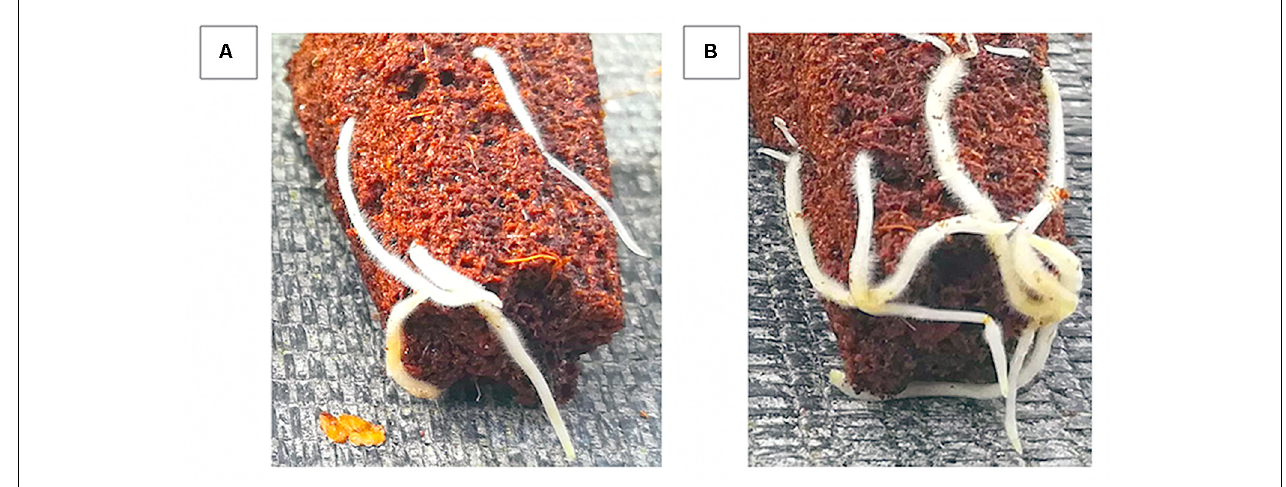
FIGURE 10 | Effect of different auxin treatments on morphology of rootstock GF677 roots. (A) IBA-K (3 µ M); (B) diluted IAA-E C1 solution (IAA = 1 µ M).